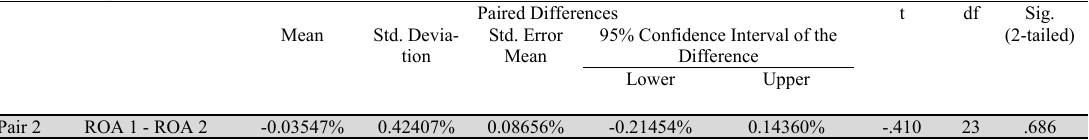
Pair 1 Paired sample T-test SMEs ROA